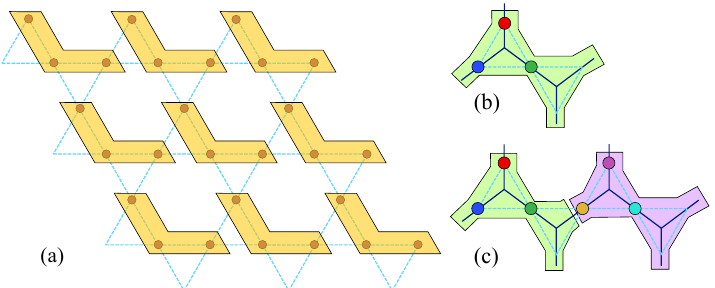
Figure 2: (Color online) (a) Coarse-graining the kagome lattice to a square net- work of block sites with three spin- 1 in each block and a total local Hilbert space of 2 d = 2 3 = 8. The iPEPS simulations were performed on 2 × 2 and 4 × 4 unit-cells of block-sites with 12 and 48 spins, respectively. (b) Coarse-graining of a PESS with three physical tensors and two simplices into a block-site. (c) Coarse-graining of a PESS with six physical tensors and four simplices into